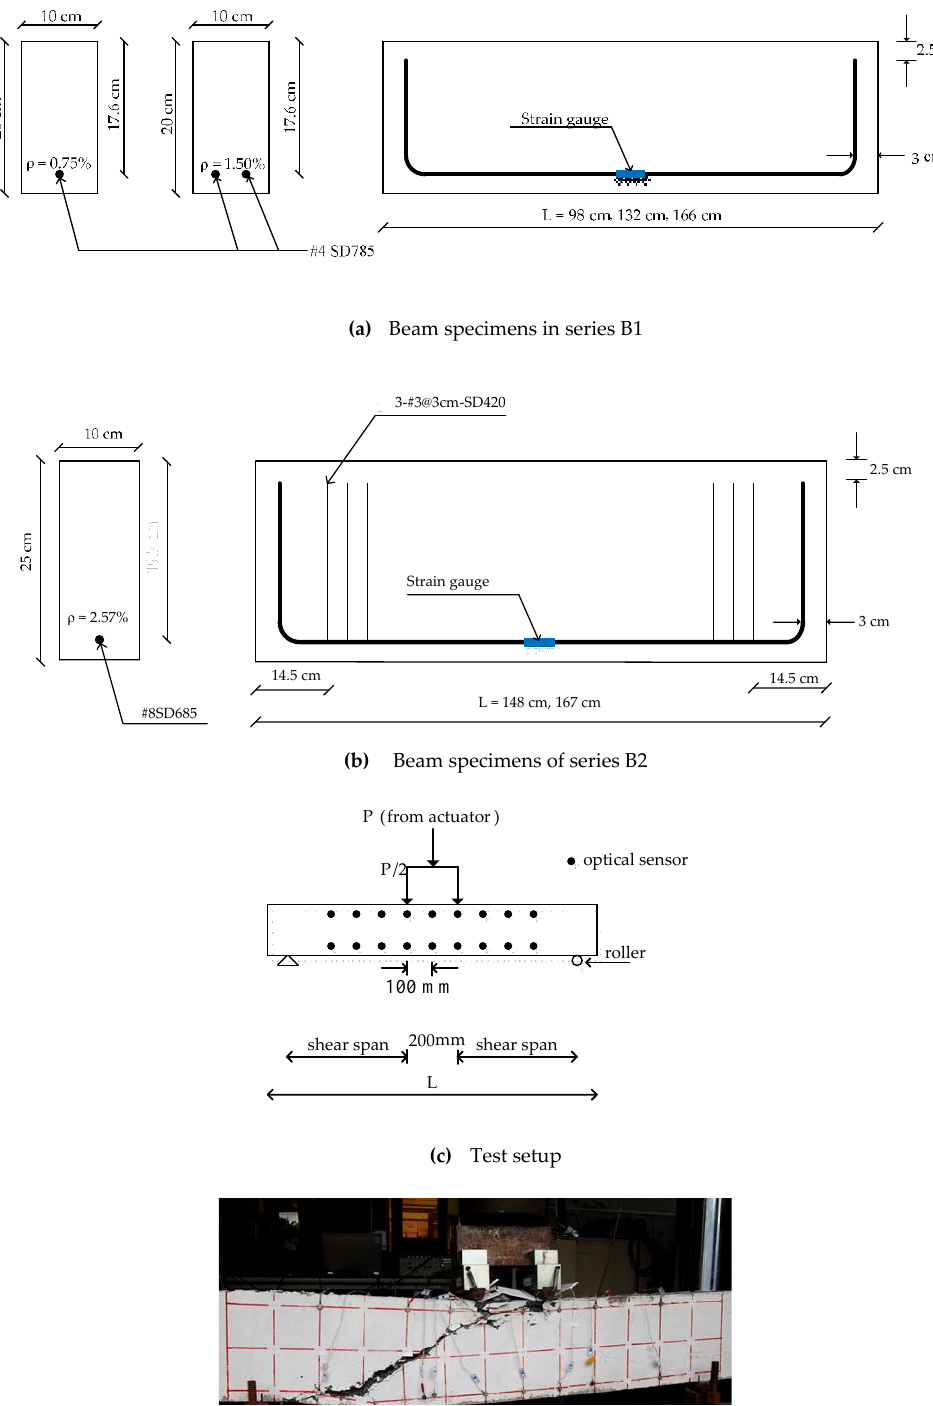
Figure 4. Specimen design, test setup and configuration of instruments, and a beam subjected to monotonic two point vertical loads.